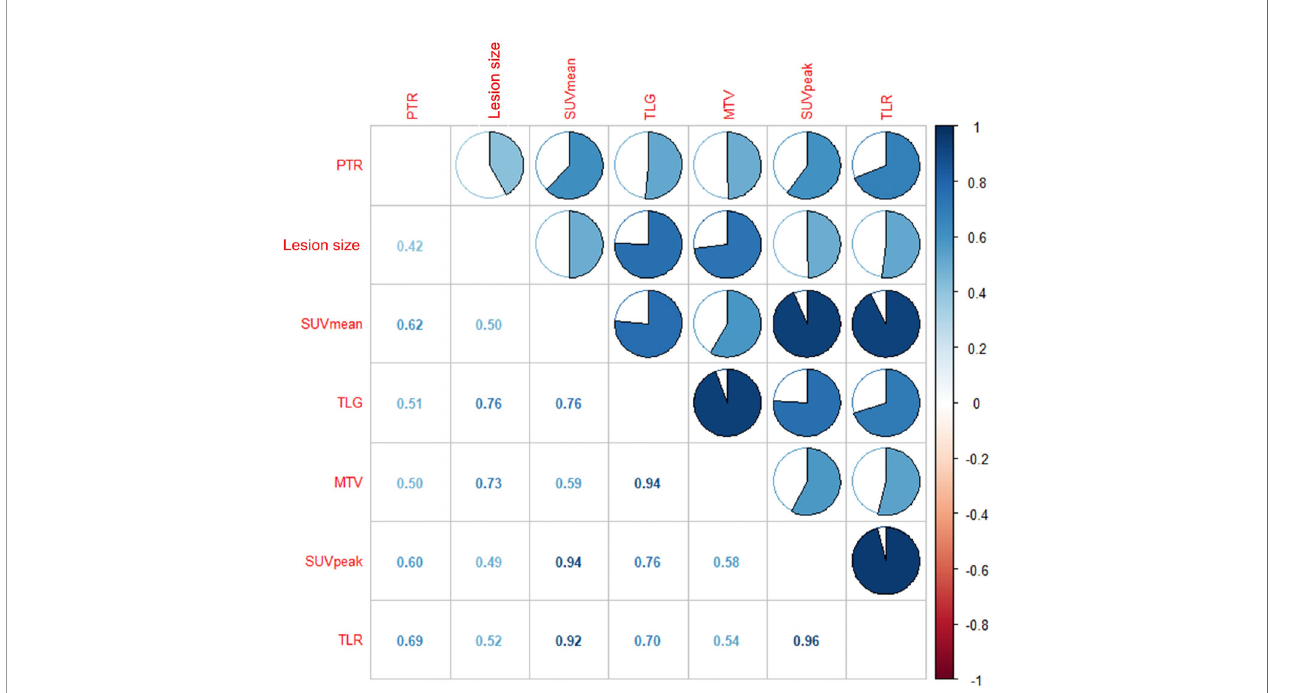
FIGURE 3 | The results showed that moderate correlation between TLR and pathological treatment response (r = 0.69, P < 0.01), SUVmean and pathological treatment response (r = 0.62, P < 0.05), SUVpeak and pathological treatment response (r = 0.60, P < 0.05),